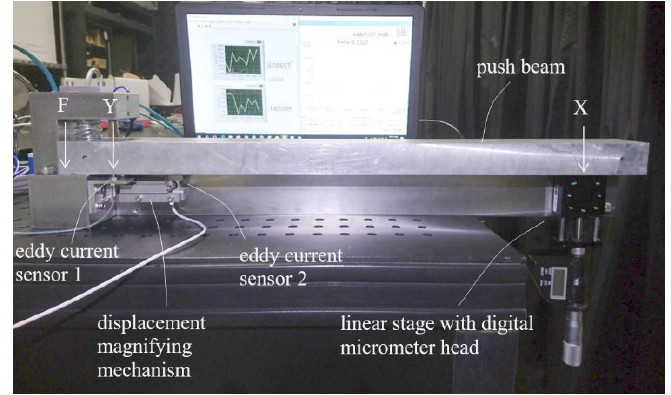
Figure 16. Setup for testing/calibrating the LCMDS prototypes.